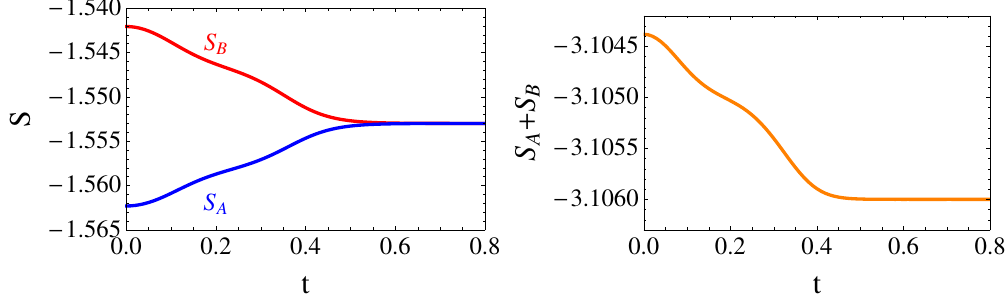
Figure 24 . (Left) Renormalized entanglement entropies S A and S B as a function of time, in a system with d = 3. (Right) Renormalized entanglement entropy S A + S B as a function of time. In both (cid:12)gures we have considered the linearized background computed in refs. [96, 97], the intervals x A 2 [0 : 05 ; 0 : 275] and x B 2 [ (cid:0) 0 : 275 ; (cid:0) 0 : 05], and temperatures T L = 0 : 6 and T R = 0 : 5. We have set G = 1 and L = 1.